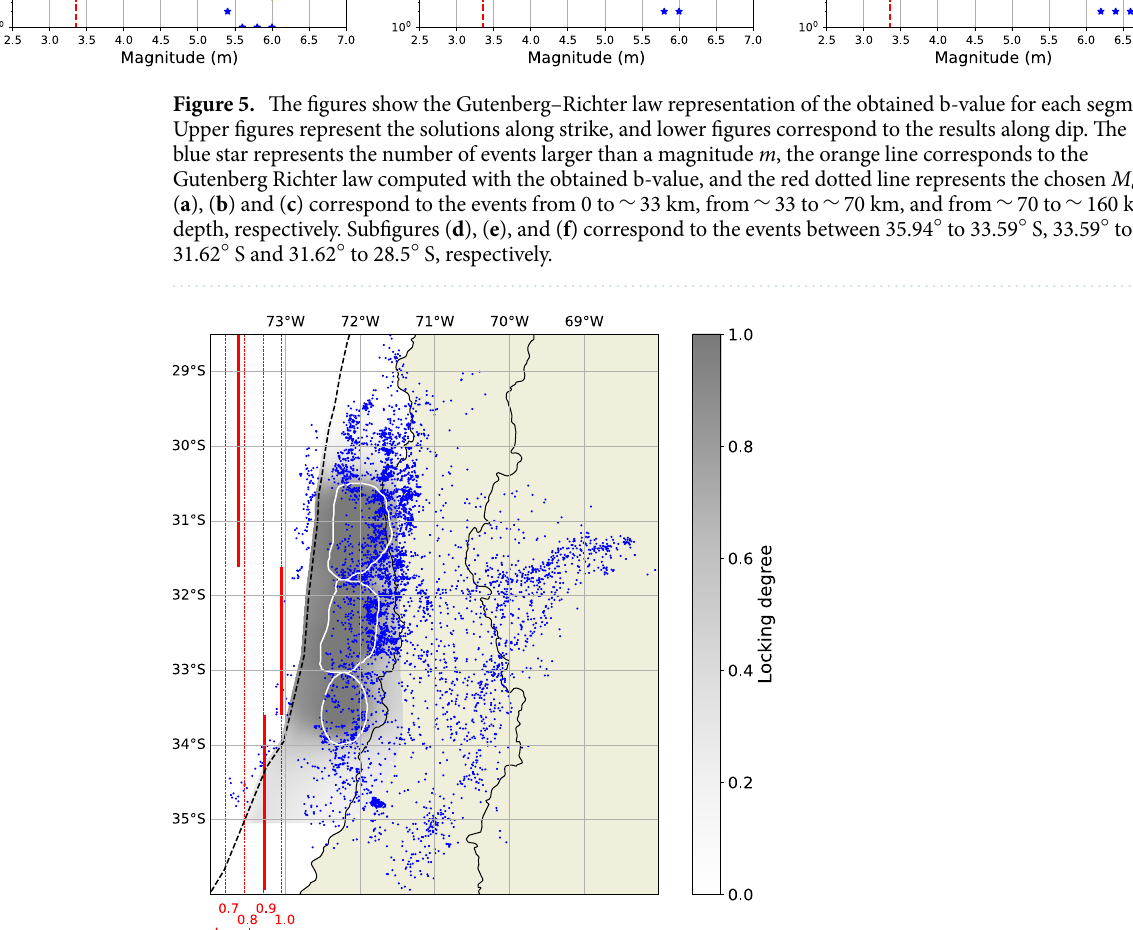
Figure 6. The map shows the b-values obtained in the present study in red, with the locking degree (greyscale) and the asperities (white line) proposed by Sippl et al. 34 . It also shows the seismicity used in the study (blue dots) and the trench (dashed line). This figure was created using Python 3.8.13 50 , Matplotlib 3.5.2 51 and Cartopy 0.21.0 52